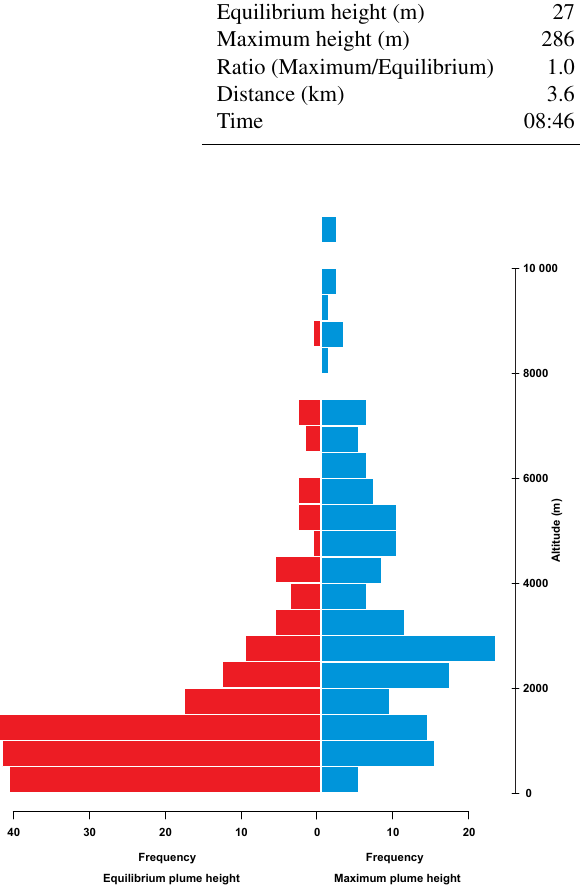
Figure 3. Histogram of equilibrium and of maximum plume heights